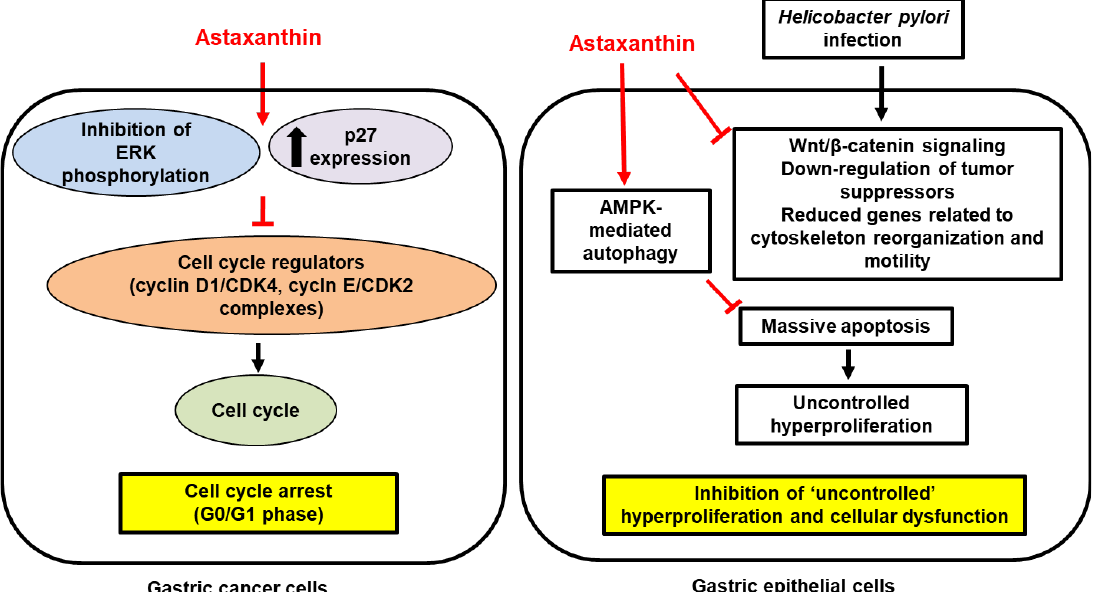
Figure 2. The inhibitory effect of astaxanthin on hyperproliferation and cellular dysfunction in gastric cancer development and progression. In gastric cancer cells, astaxanthin inhibits phosphorylation of extracellular signal-regulated kinase (ERK) but stimulates expression of tumor suppressor p27 that inhibits the formation of cell cycle regulators such as cyclin D1/cyclin-dependent kinase 4 (CDK4) and cyclin E/CDK2 complexes, leading to cell cycle arrest at G0/G1 phase. In Helicobacter pylori -infected gastric epithelial cells, astaxanthin increased 5’ adenosine monophosphate-activated protein kinase (AMPK)-mediated autophagy, resulting in inhibition of massive apoptosis and uncontrolled hyperproliferation. Helicobacter pylori infection activates Wnt/ β -catenin signaling pathway. However, it decreases expression of tumor suppressors and genes related to cytoskeleton reorganization and motility. Therefore, astaxanthin inhibits hyperproliferation and cellular dysfunction in the pathogenesis of gastric cancer development. Inhibit, ; increase, . Red arrows represent the effects of astaxanthin.